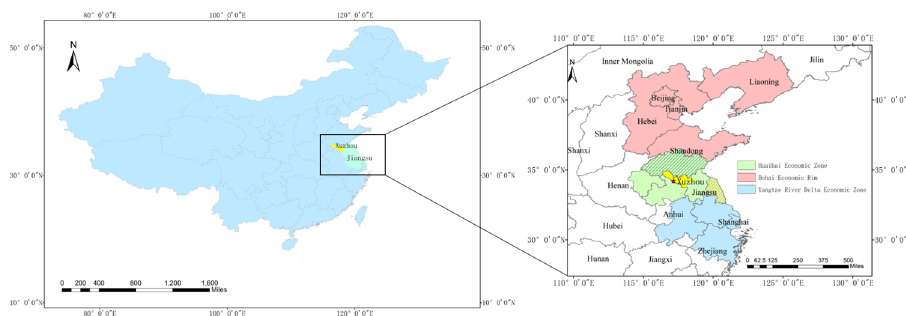
Figure 1. Location of the study area, an industrial city in central China: Xuzhou.